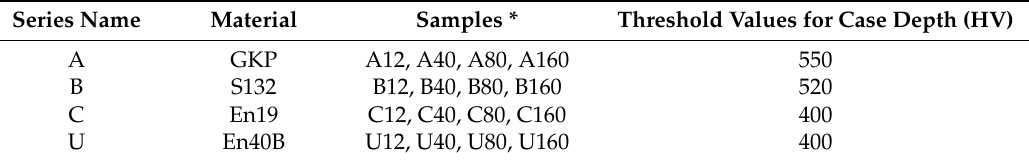
Table 1. Materials used.